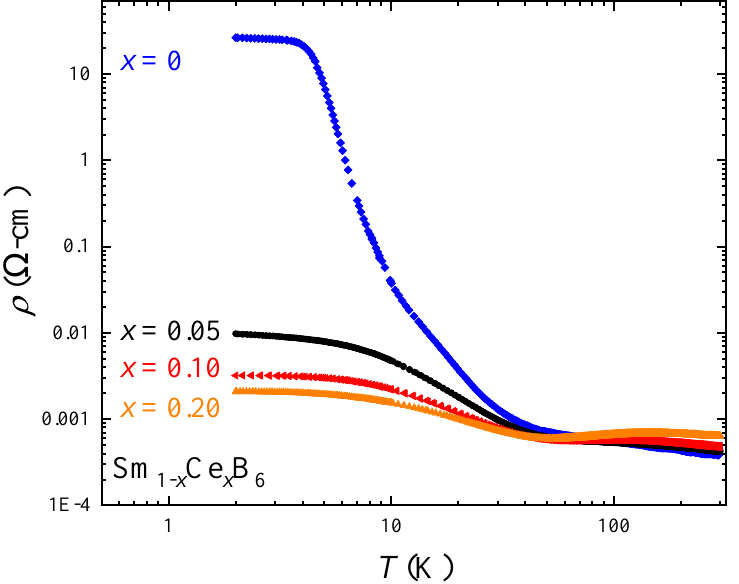
Figure 4. ( a ) Temperature dependence of the dc magnetic susceptibility, χ versus T , in the temperature range 1.8–100 K for the Sm 1 − x Ce x B 6 ( x = 0, 0.05, 0.10 and 0.20) crystals, with a magnetic field applied along the [001] (black), [110] (red) and [111] (orange) crystallographic directions. The previously reported susceptibility data for a SmB 6 crystal [57] are given for comparison. The inset shows χ versus T , on a logarithmic scale, in the temperature range 1.8–300 K. ( b ) Temperature dependence of the reciprocal of the dc susceptibility, χ − 1 versus T , of Sm 1 − x Ce x B 6 for a field applied along the [001] direction. The inset shows the normalised magnetic susceptibilities of Sm 1 − x Ce x B 6 samples, with a magnetic field applied along the [001] direction. The χ / χ (10 K) versus T data increase rapidly at low temperatures, but with no signature of long-range magnetic order, for all Ce concentrations.